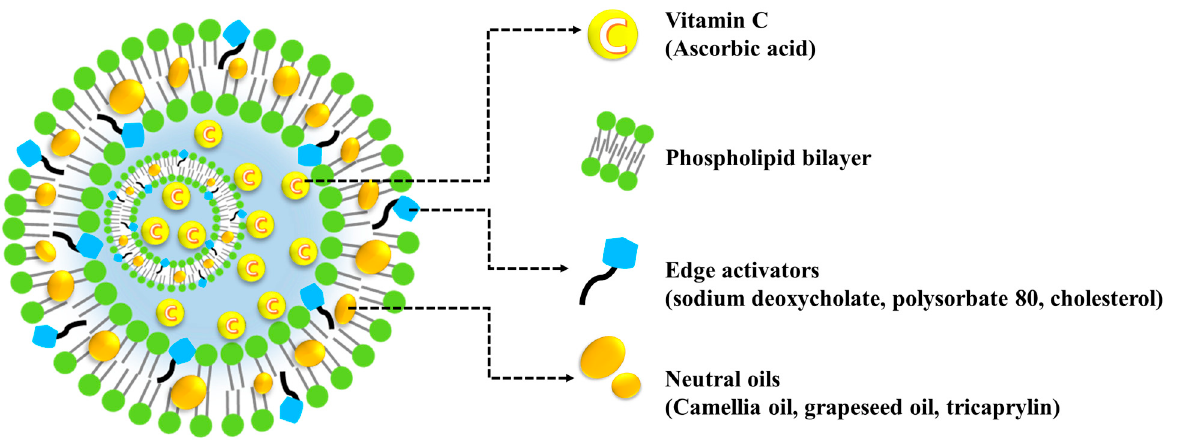
Figure 1. Schematic illustration of the configuration of Vit C-loaded lipo-oil-somal